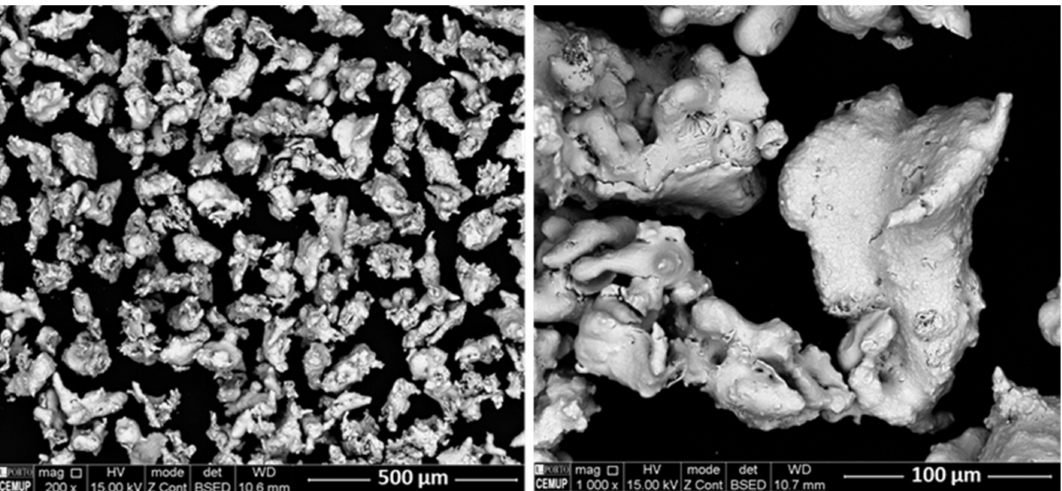
Figure 1. Scanning electron microscopy (SEM) images of martensitic stainless-steel powder (Metco 42C).